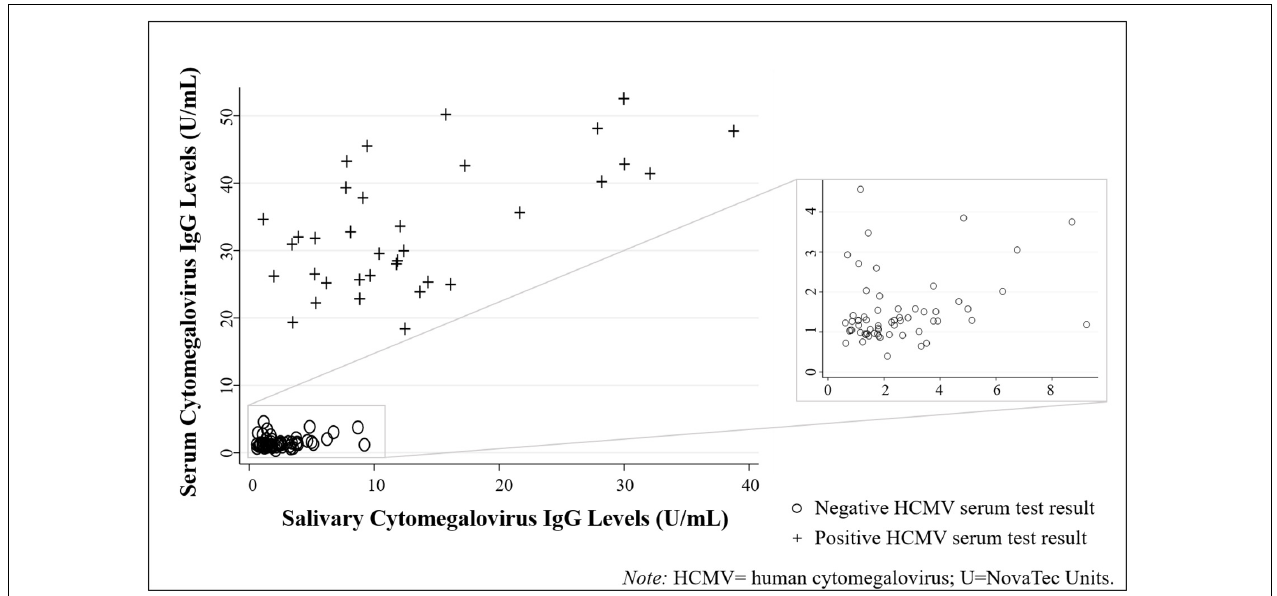
Table 4 shows the serum and salivary HCMV IgG test results. Using the serum test result as the indicator of infection status, the saliva test showed a sensitivity of 51% and a specificity of 97%. Every participant with a positive salivary HCMV IgG test also had a positive serum test (100% positive predictive value), and 87% of participants with a negative salivary HCMV IgG test also had a negative serum test (87% negative predictive value).